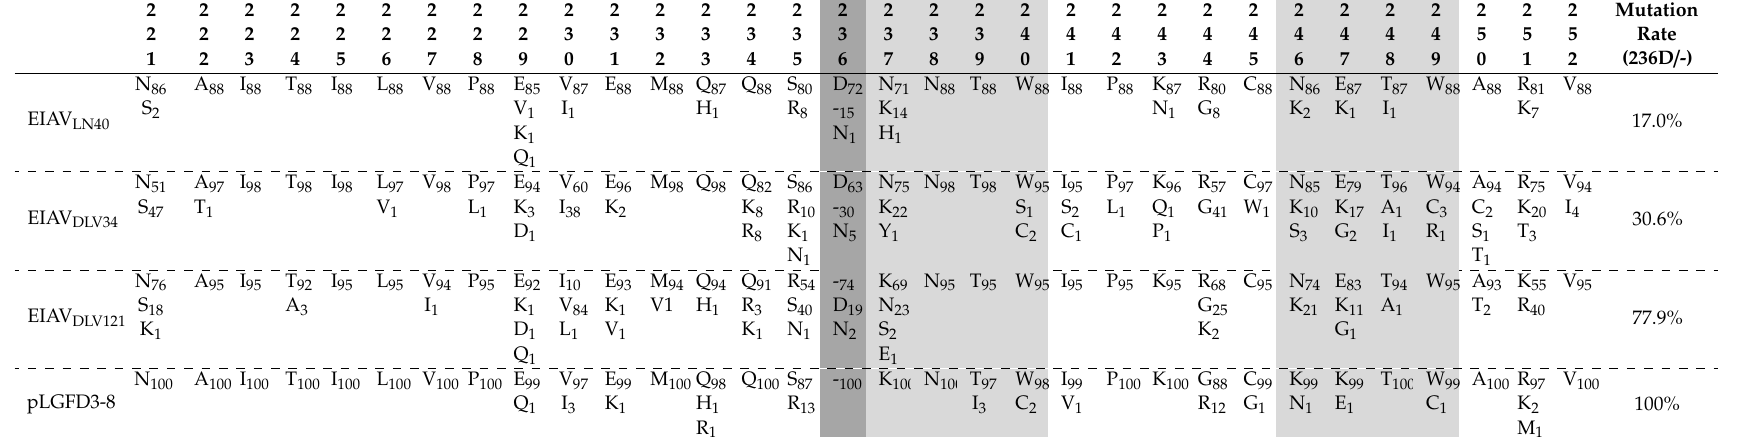
The additional amino acid D, which consistently appeared in virulent EIAV strains, is marked with dark grey, and N-linked glycosylation sites are marked with light